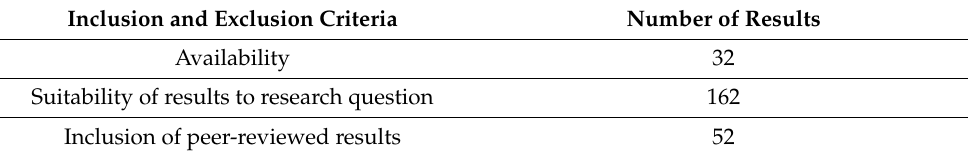
Table 1. Quantification of